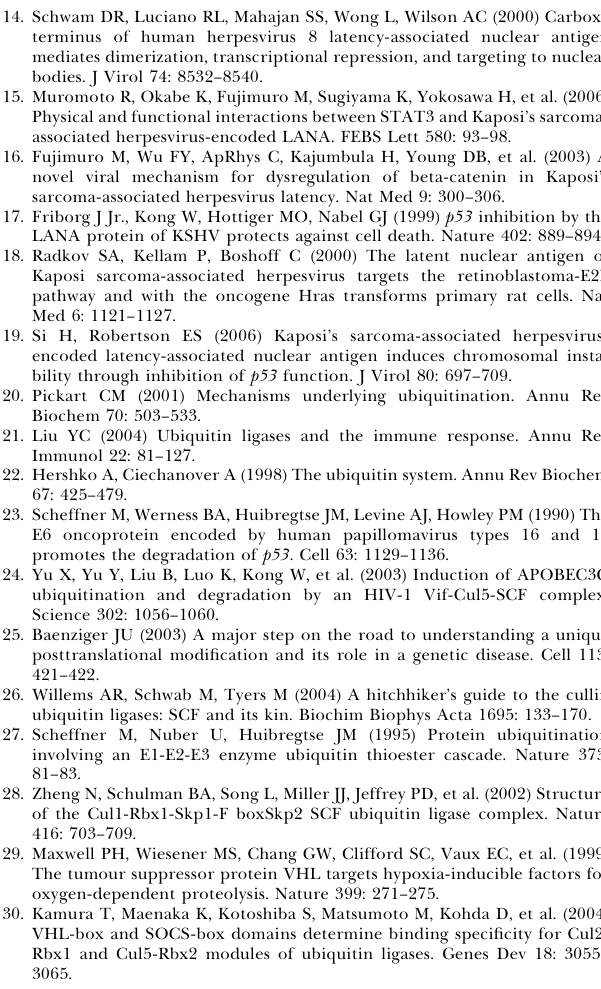
Figure S3. Proposed Model for Viral Protein LANA Interacts with Cellular Protein VHL and p53 During virus invasion, KSHV-encoded LANA is aberrantly expressed and possesses cellular EC 5 S ubiquitin complex to induce